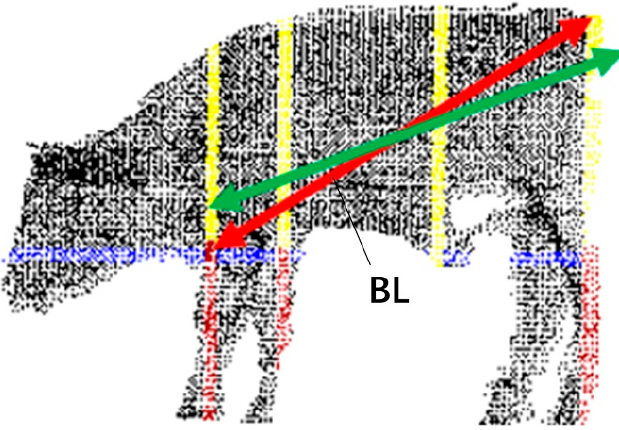
Figure 22. The location of beef cattle body oblique length